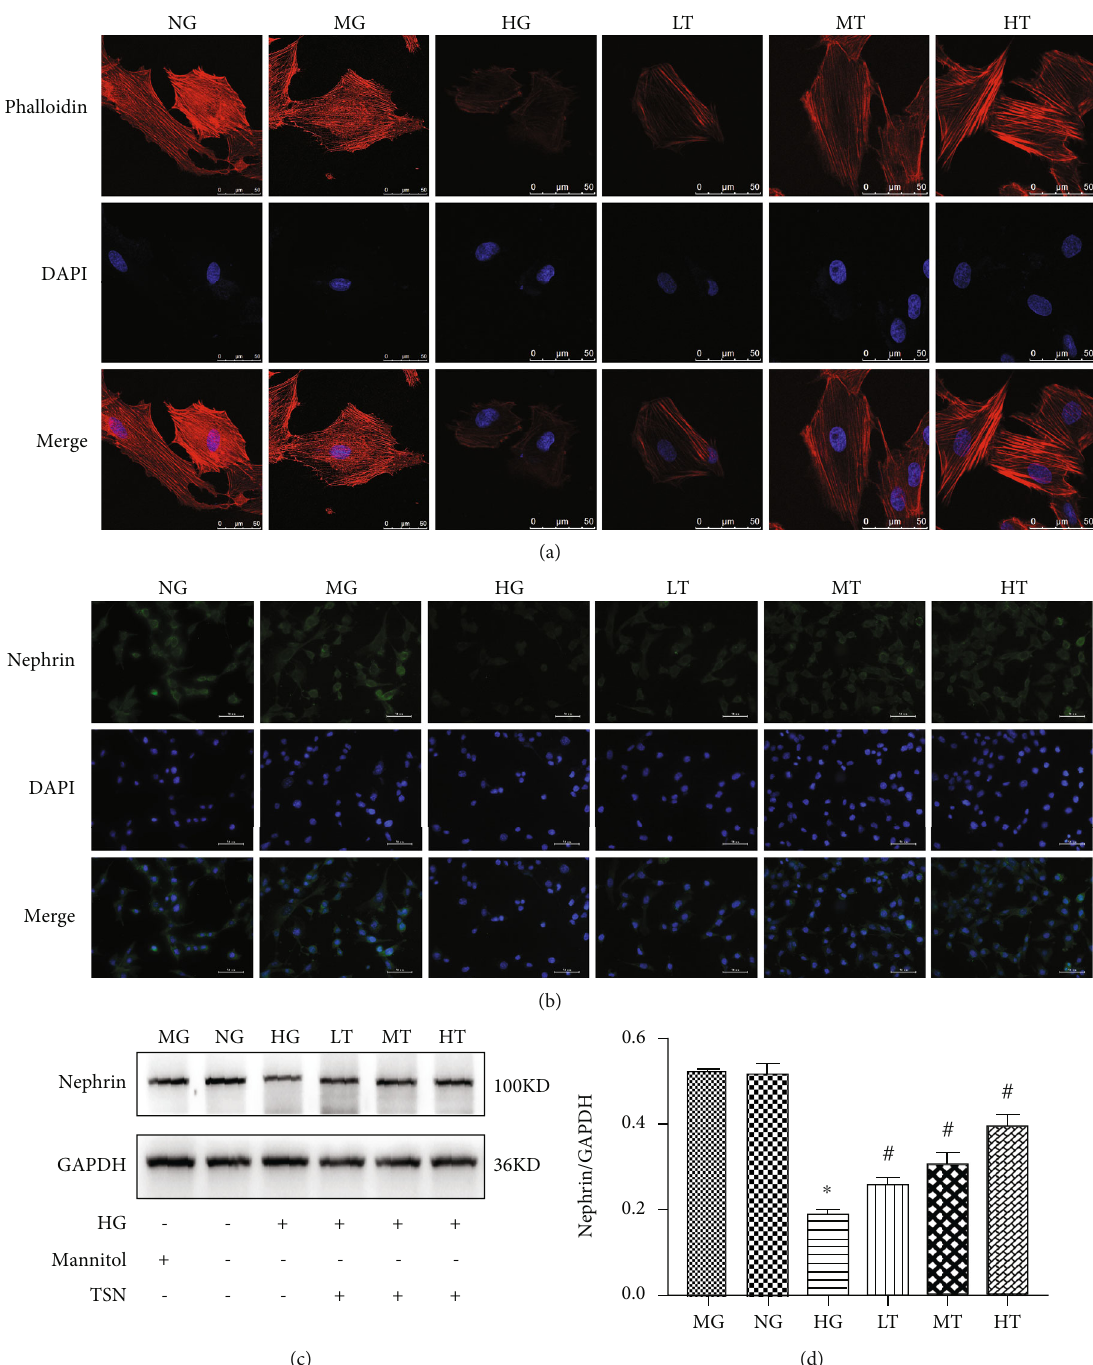
Figure 4: E ff ects of TSN on nephrin expression and podocyte cytoskeleton in high glucose-induced podocytes. (a) Staining of podocytes cytoskeleton with phalloidin, original magni fi cation × 630, scale 50 μ m, n = 3 . (b) Representative immuno fl uorescence photographs of nephrin in each group, magni fi cation × 400, scale 50 μ m, n = 3 . (c – d) Representative Western blot band and quanti fi cation of nephrin protein expression in each group, data were shown as the mean ± SD , n = 3 ; ∗ P < 0 : 05 versus the NG group, # P < 0 : 05 versus the HG